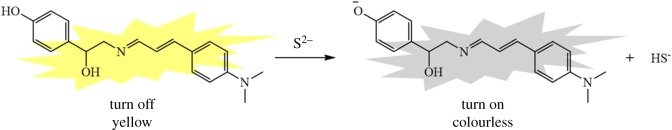
The proposed sensing mechanism of 1 toward sulfide.